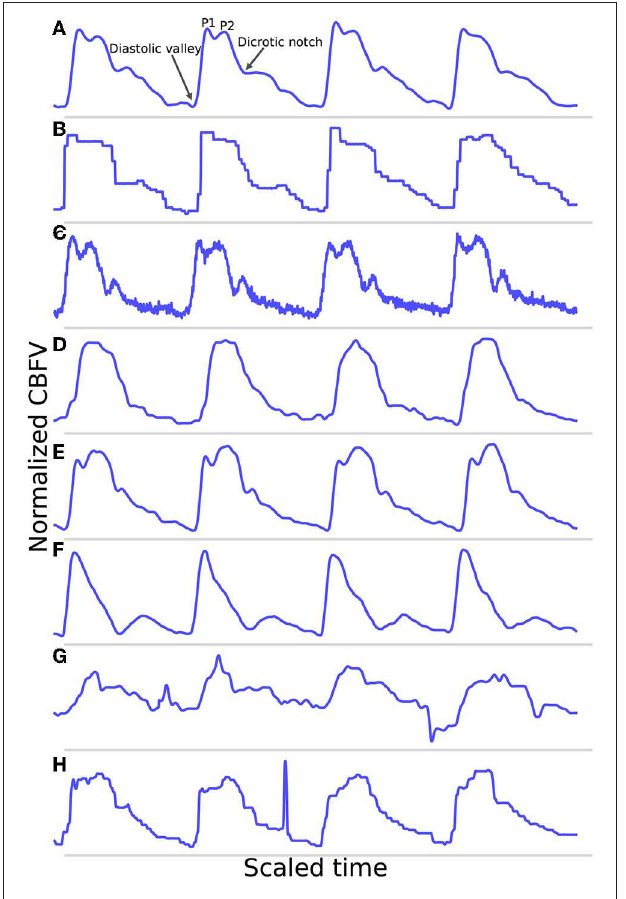
FIGURE 1 | Shown are samples taken from the data set. (A) Shows a good quality, healthy waveform for reference. (B) Demonstrates a common measurement error that results in signal with a digitized appearance. (C) Shows a signal with a significant high frequency noise component. (D) shows an example of a blunted waveform. (E) Shows a waveform with an elevated P2. (F) Shows a potentially stenotic waveform. (G) Demonstrates a signal with extremely poor quality. And finally, (H) illustrates a signal with a sharp noise spike.